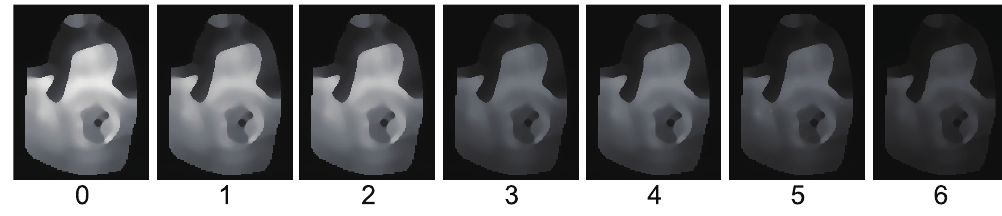
Figure 20. The results for doll object, which causes strong specular reflection. Estimated albedo is shown, which is smooth enough.